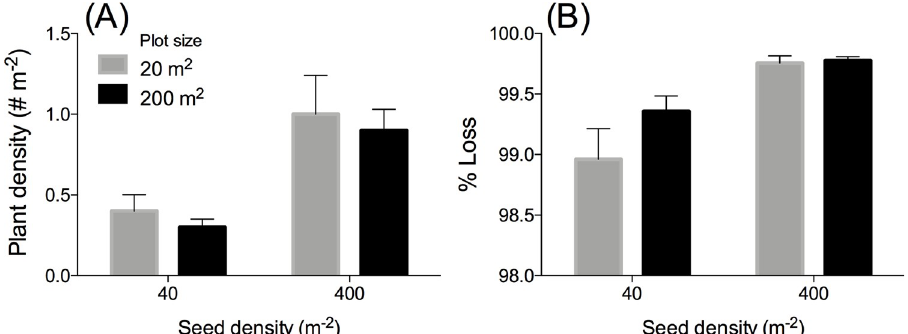
Fig 5. Results restoration experiment Uithuizen 2017. (A) Mean plant densities (m -2 ) and (B) Loss rates (%) from seeds to seed-bearing plants.